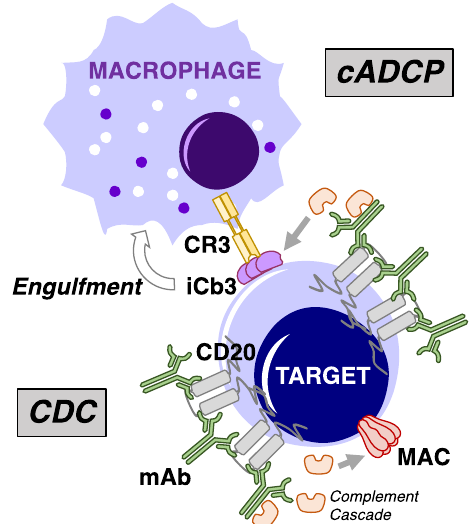
Figure 1. Overview of cytotoxic mechanisms underlying mAb-mediated complement fixation. Depiction of type I anti-CD20 mAb binding to surface of target cells. Complement-dependent cytotoxicity (CDC) occurs following formation and binding of multiple copies of the membrane attack complex (MAC) on the target cell surface downstream of mAb-induced initiation of the complement cascade. Target cell killing by complement receptor-mediated antibody-dependent cellular phagocytosis (cADCP) results from mAb-mediated deposition and covalent binding of C3 activation fragments to the cell surface, which are in turn recognized by complement receptors (CR3 is shown) which trigger activation of phagocytic pathways in phagocytes such as macrophages.